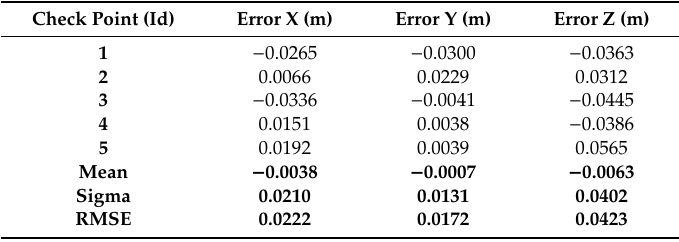
Table 3. The leave-one-out method applied to assess the structure-from-motion (SfM)